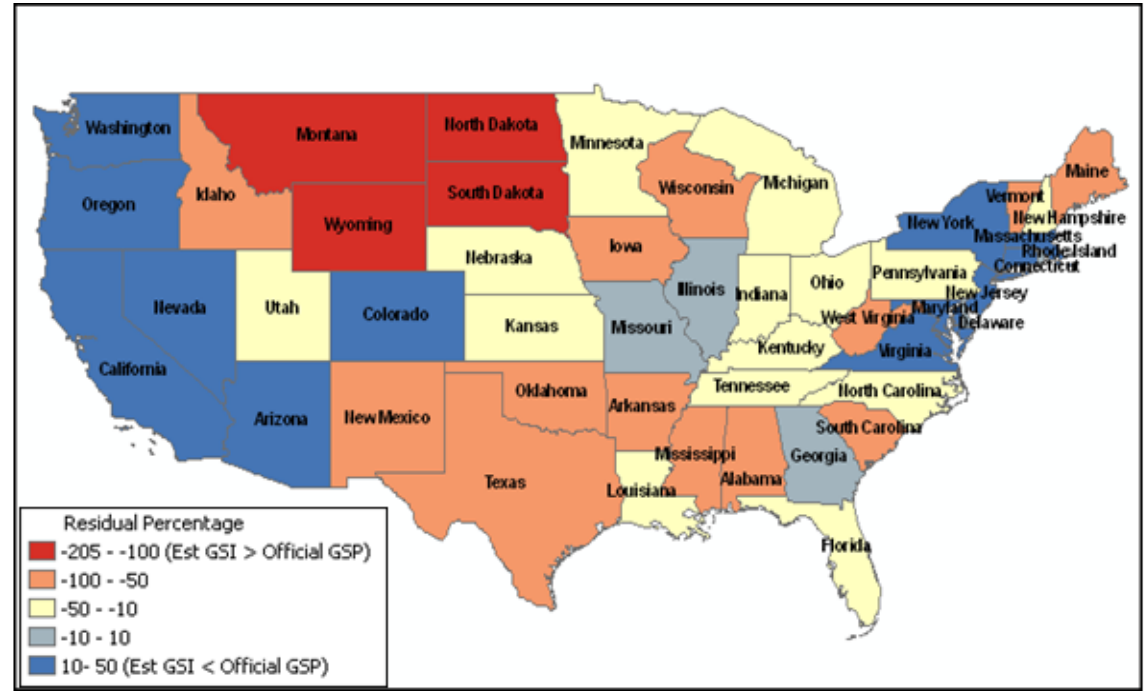
Figure 13. Map of the Percentage Residual Gross State Product by U.S. state.